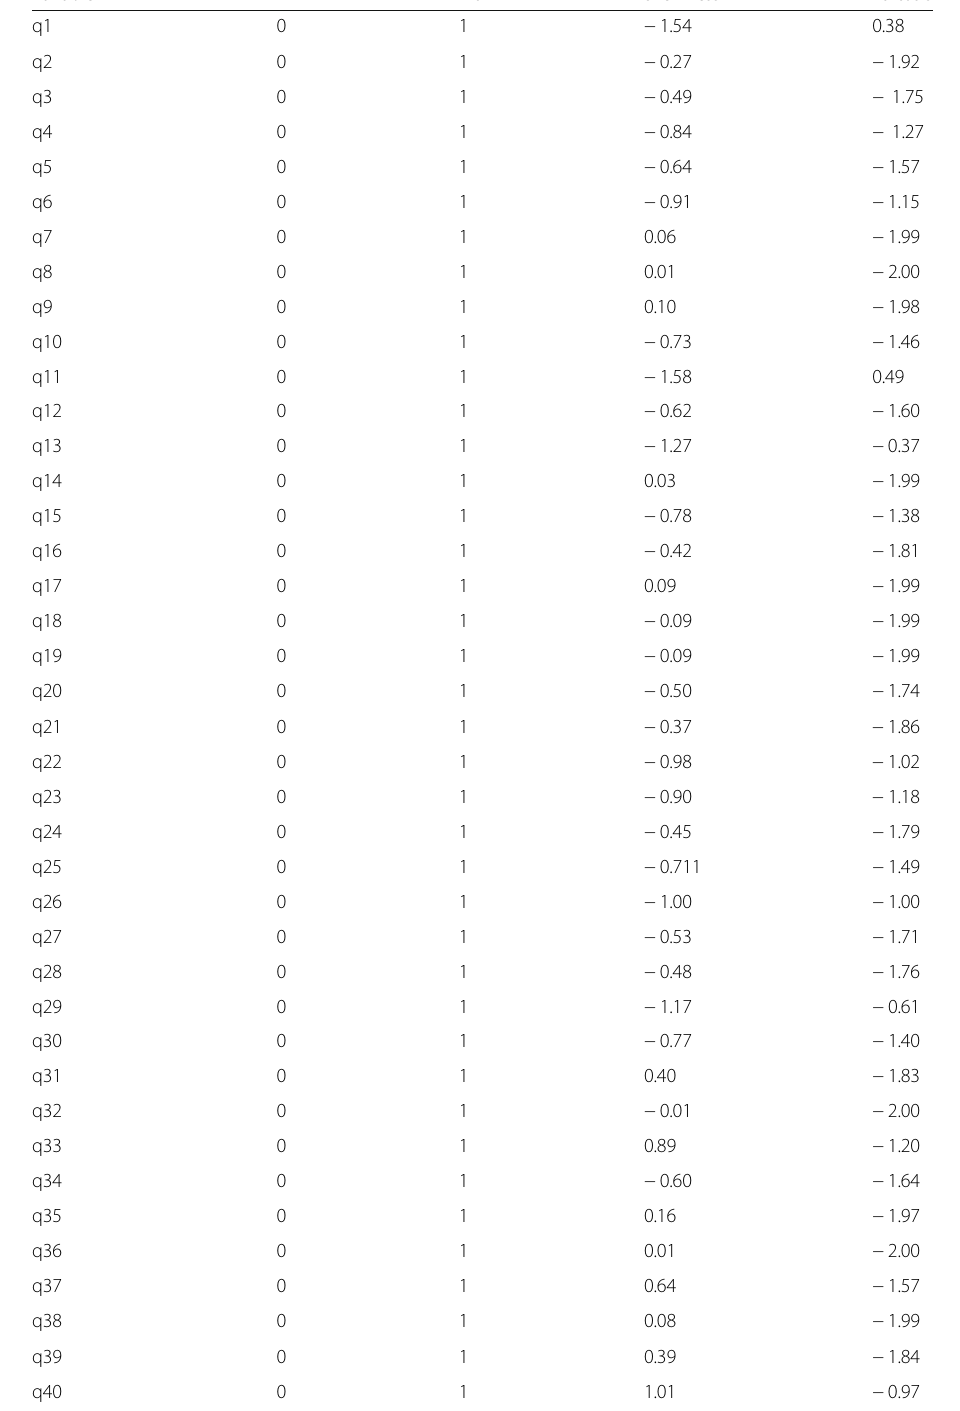
Table 5 Tests of univariate and multivariate